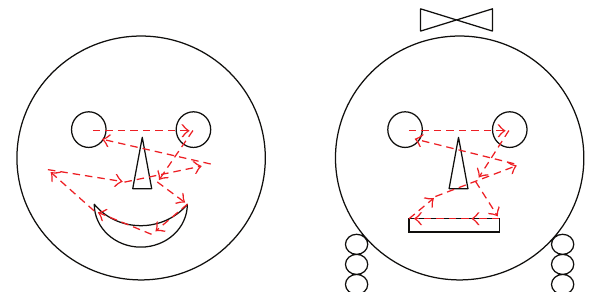
Figure 7: Artificial images showing eye gaze on a face, for illustration only. Note similarity of eye-gaze path near eyes, but not near